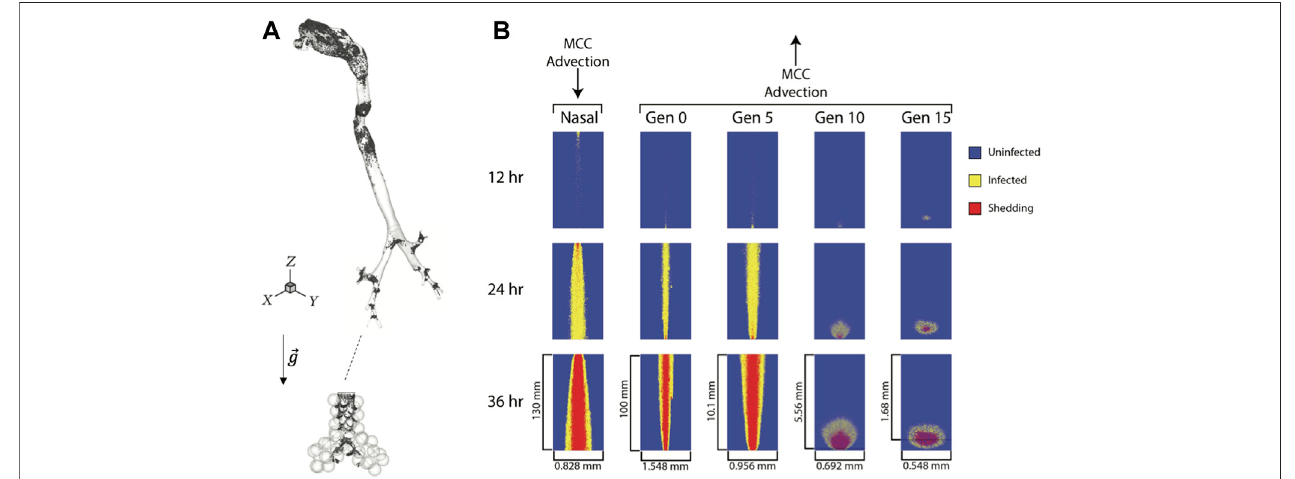
FIGURE 3 | Viral particle deposition and spread of infected cells. (A) Deposition patterns of 1 µm particles inhaled at a fl ow rate of 0.5 L/s in a model of the human lung highlighting the heterogeneous natureofdepositionpatternsboth in the conducting airways and in thealveolar region (not toscale), (cid:1) g : gravity vector(modi fi edfrom (Li et al., 2014) and (Ma and Darquenne, 2011)). (B) Snapshots of the spread of infected epithelial cells from a single infected cell in the nasal passage, trachea (Gen 0), Gen5,10and15overaperiodof36 h.Notethehorizontalandverticalscalesforeachcolumnarespeci fi ctoeachgeneration(reproducedfrom(Chenetal.,2022) copyright 2022, with permission from